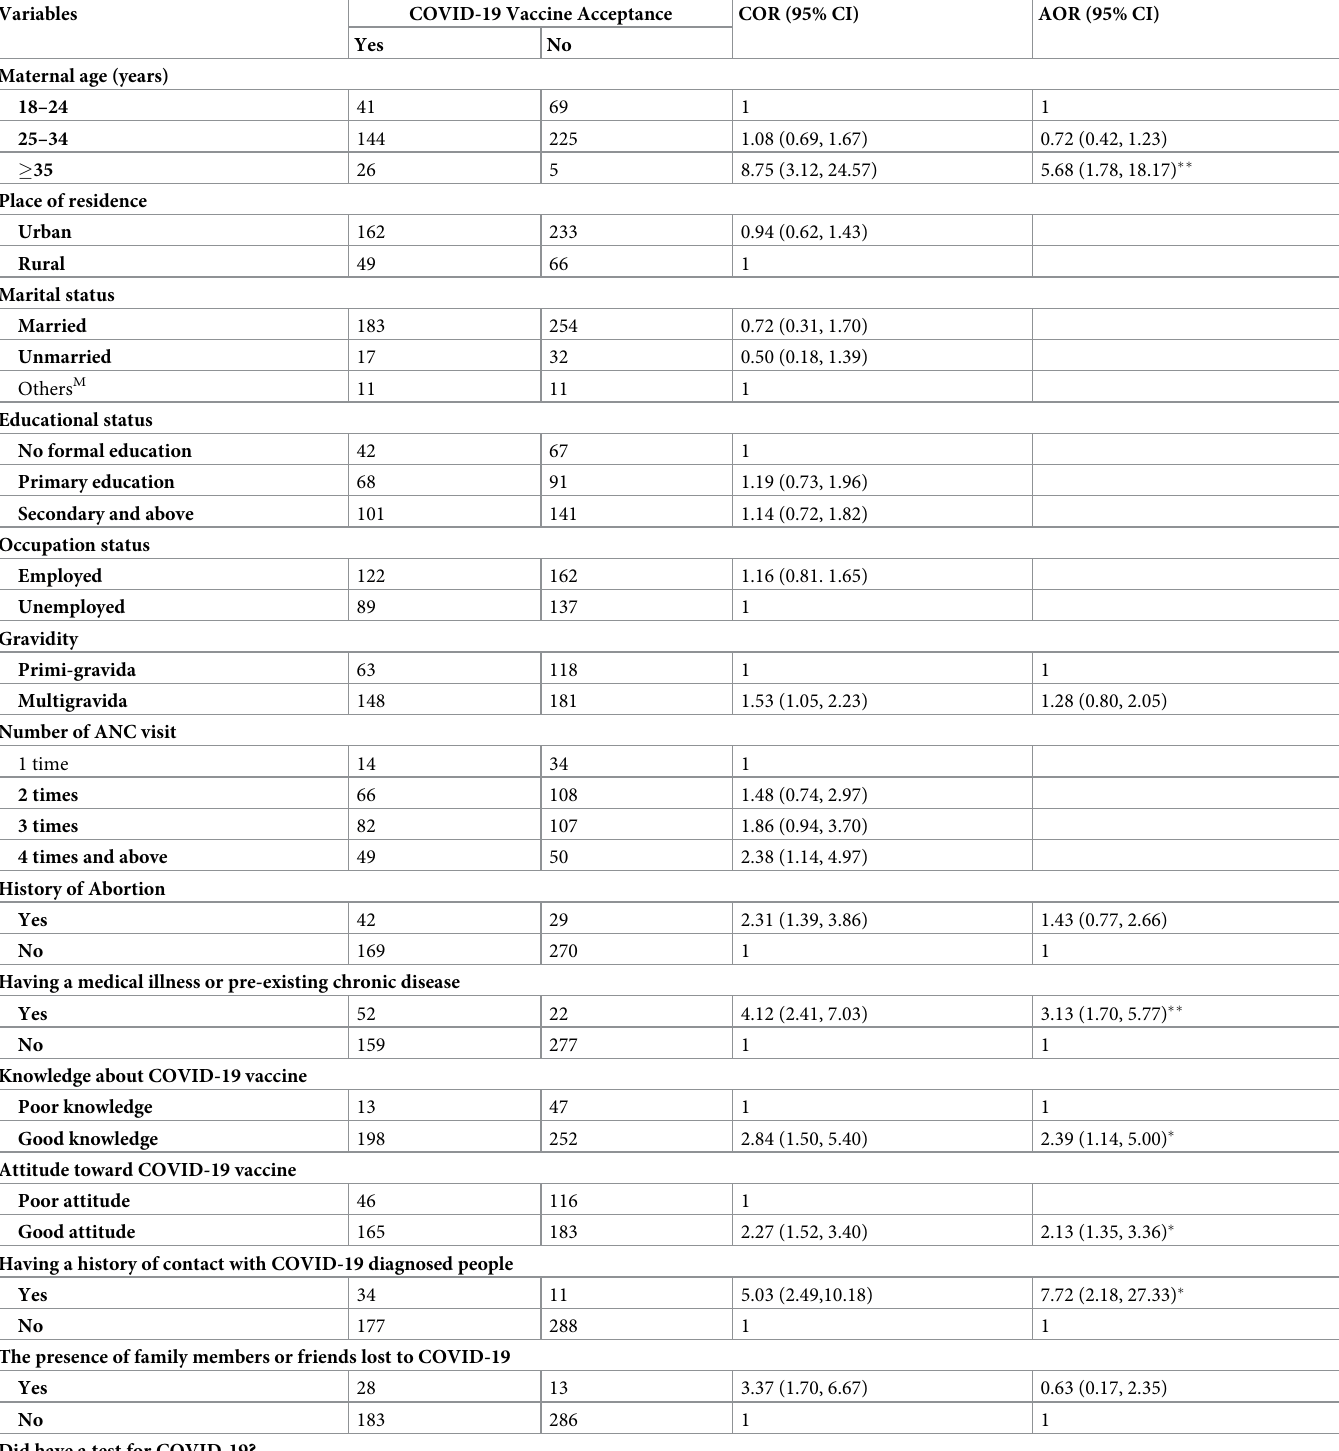
Table 4. Bivariable and multivariable analysis of factors associated with COVID-19 vaccine acceptance among pregnant woman attending antenatal care clinic at Gondar town, Northwest Ethiopia, 2021 (n =